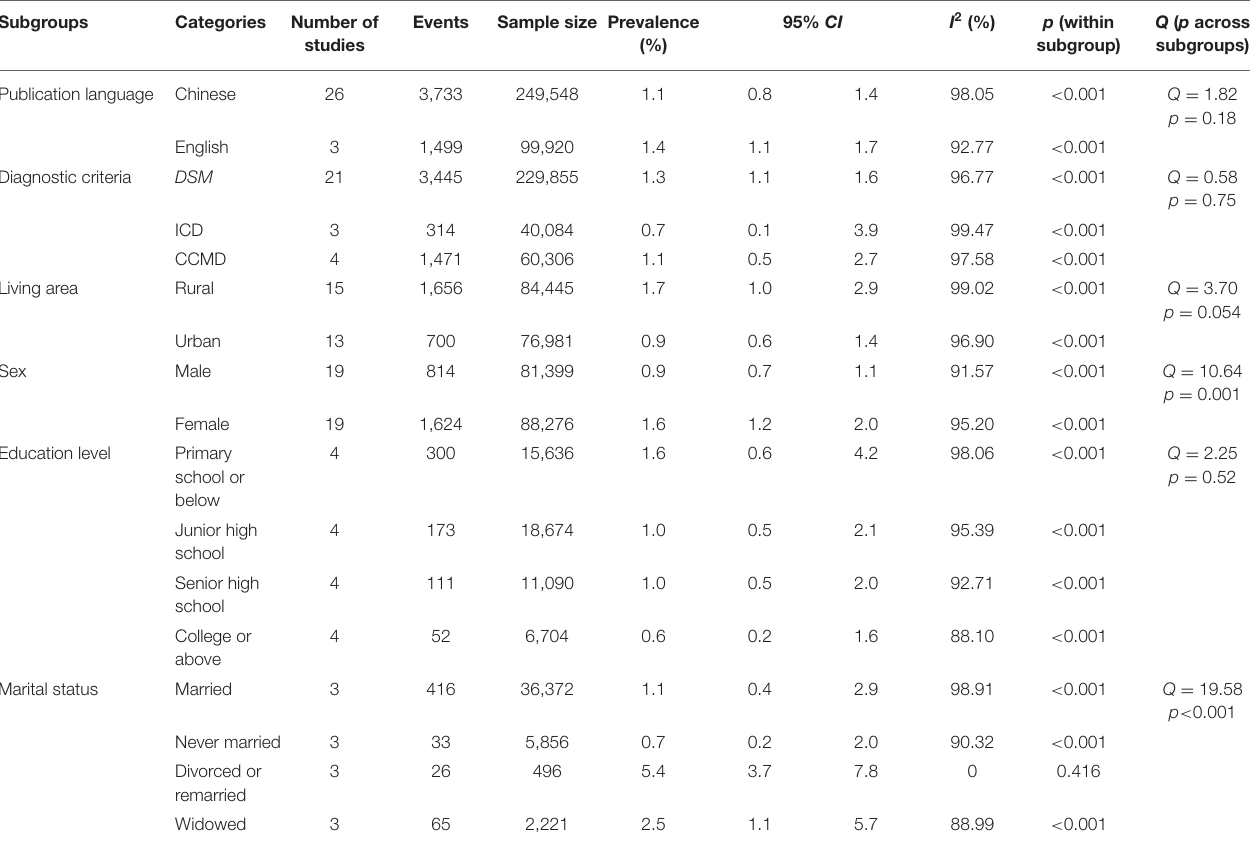
TABLE 3 | Subgroup analyses of point prevalence of MDD in China.